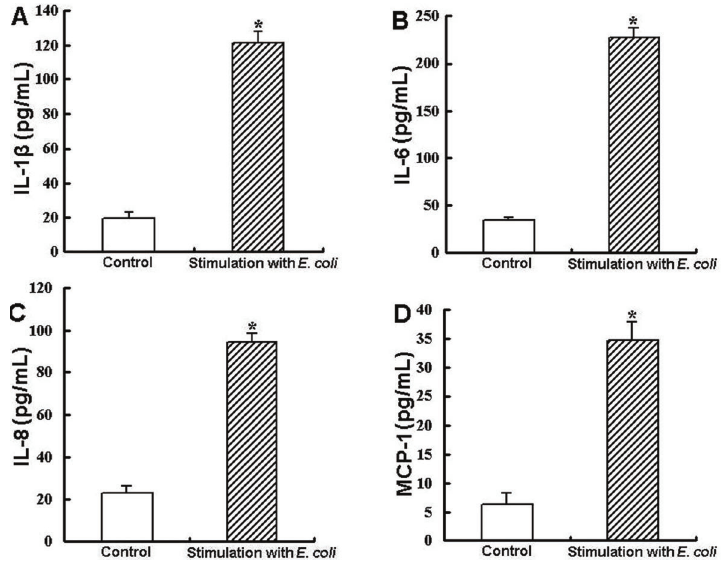
Figure 6. Secretion of cytokines by mouse intes- tinal epithelial cells (IECs) in response to E. coli . Data are reported as means ± SD. P o 0.05, com- pared to control (one-way